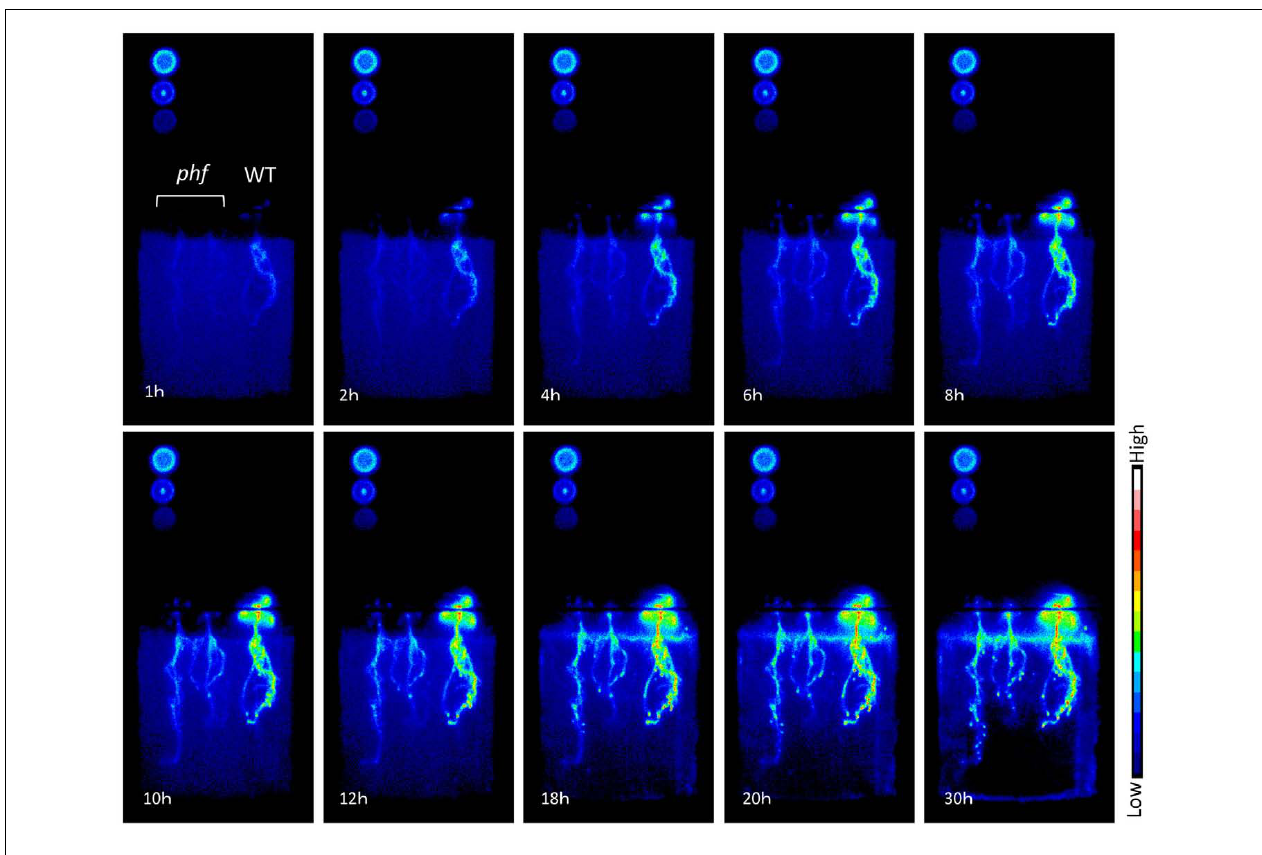
plantlet are shown. Circles on the left are 32 P standards:descending from the upper left corner, they represent 2.5, 1, and 0.5kBq/ μ l.The plants shown are 11days old, grown in vitro using 1/10 MS medium containing 500 μ M Pi and subsequently transferred to 10 μ M Pi for 3days before